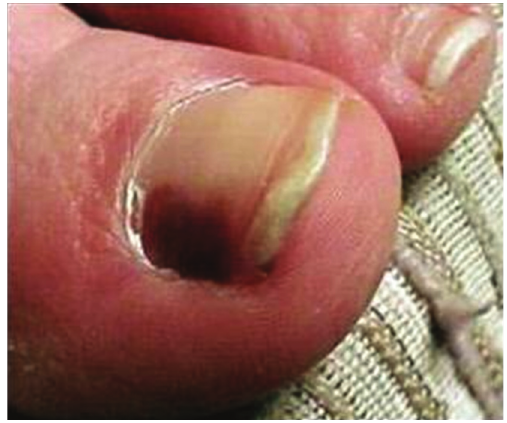
Figure 1: Subungual pigmentation.